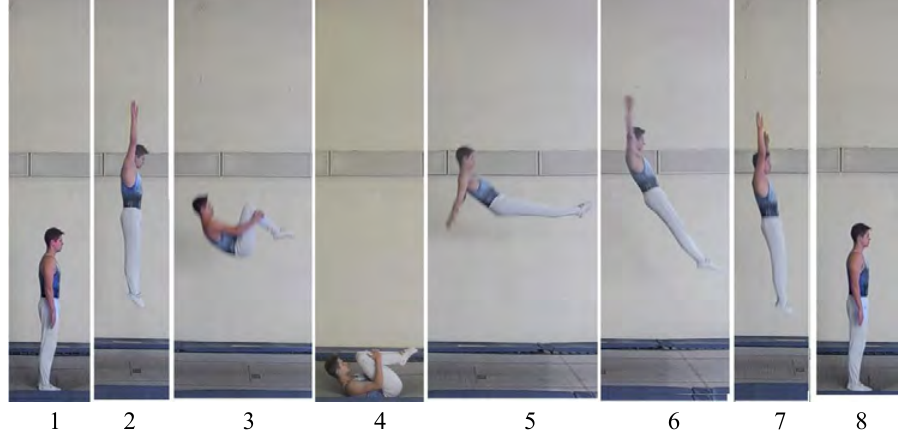
Fig.7. Backward jump with landing on back,